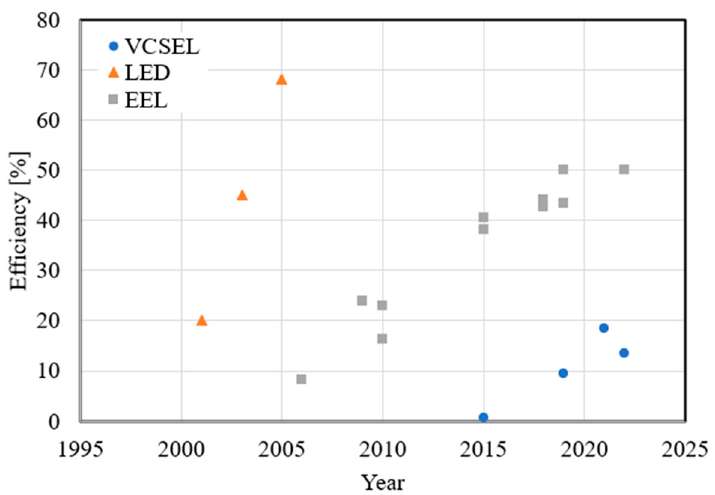
Figure 12. Efficiency trend of blue LED, EEL, and VCSELs (courtesy of T. Miyamoto and M. Figure 12. E ffi ciency trend of blue LED, EEL, and VCSELs (courtesy of T. Miyamoto and M. Ku- ramoto).